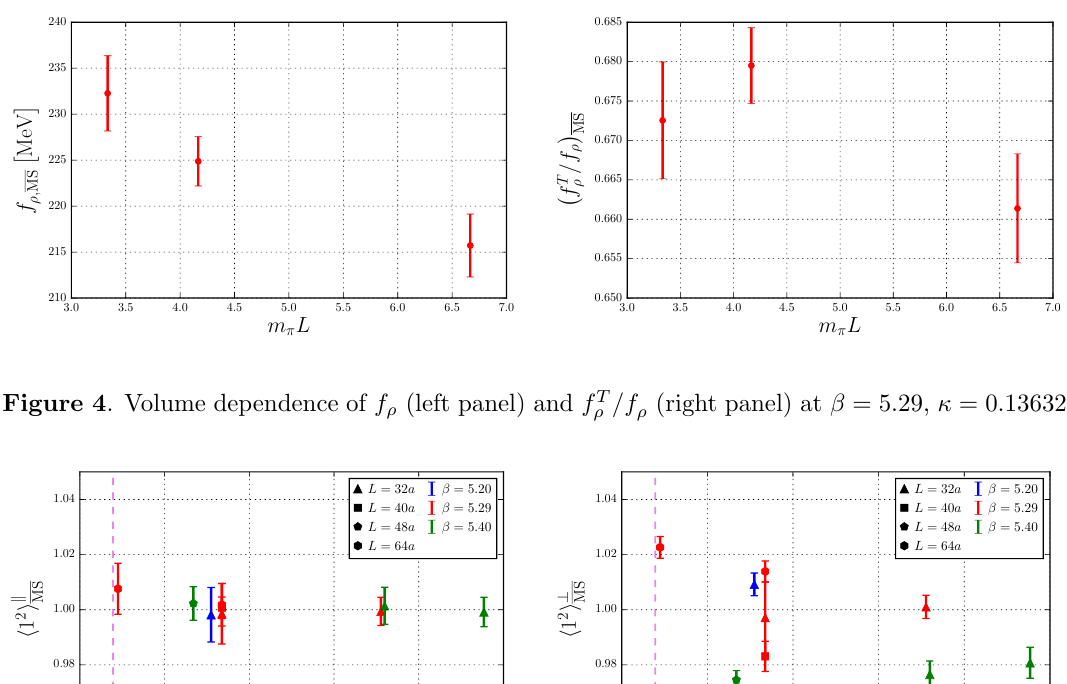
1 2 and 1 2 , respectively. The violet dashed line h i MS h i MS